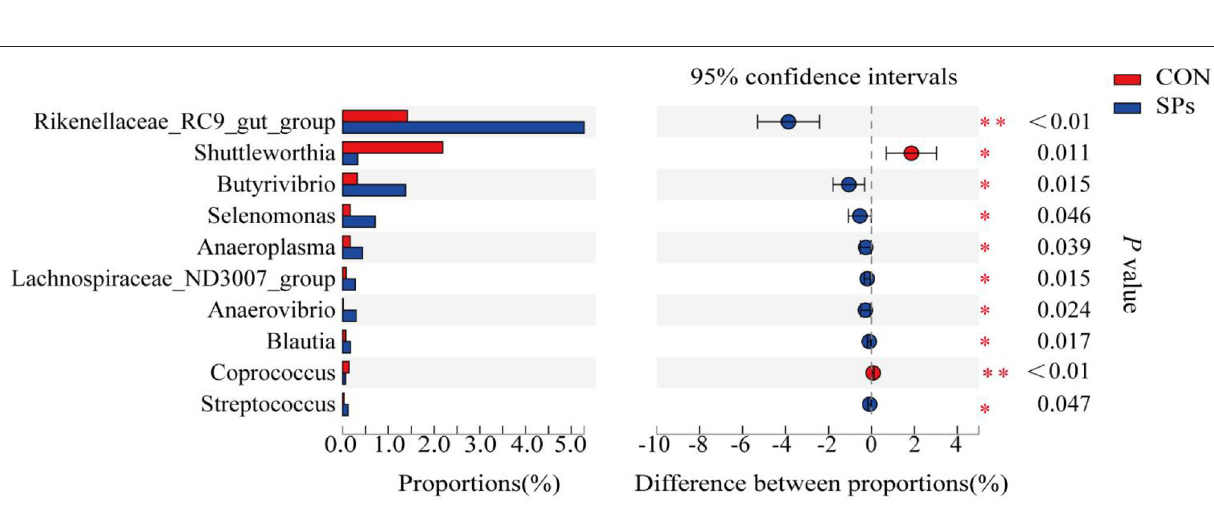
FIGURE 5 | Effects of the dietary supplementation of soybean peptides (SPs) on genera relative abundance in CON and SPs groups. *, significant differences ( p < 0.05); **, highly significant differences ( p < 0.01). CON, the control group with no soybean peptide supplementation; SPs, the group with 50 g/head/day of soybean peptide